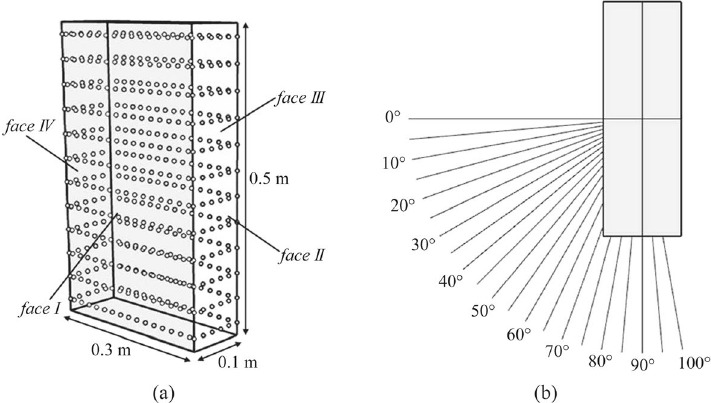
Fig. 1 The geometry of the building ( a ) and the wind incidence angles from 0 ◦ to 100 ◦ ( b